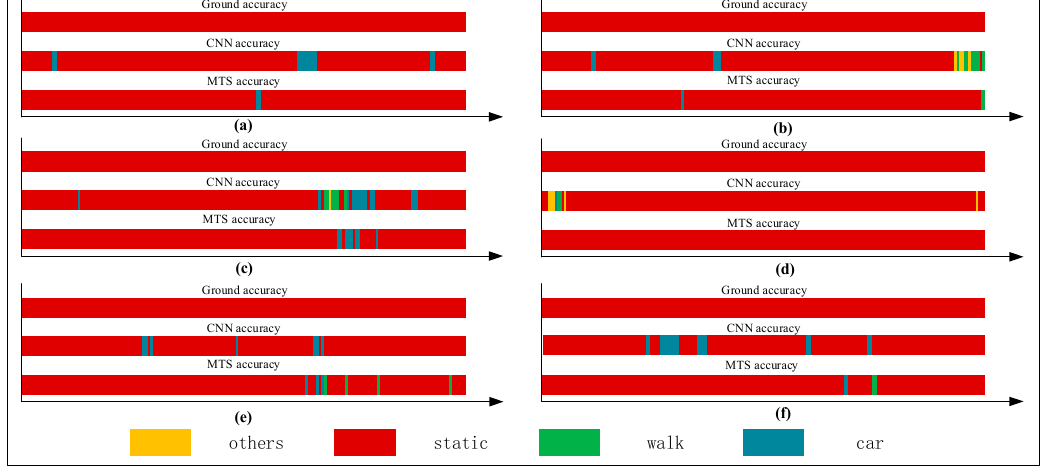
Figure 12. Graphs showing recognition of the other states.